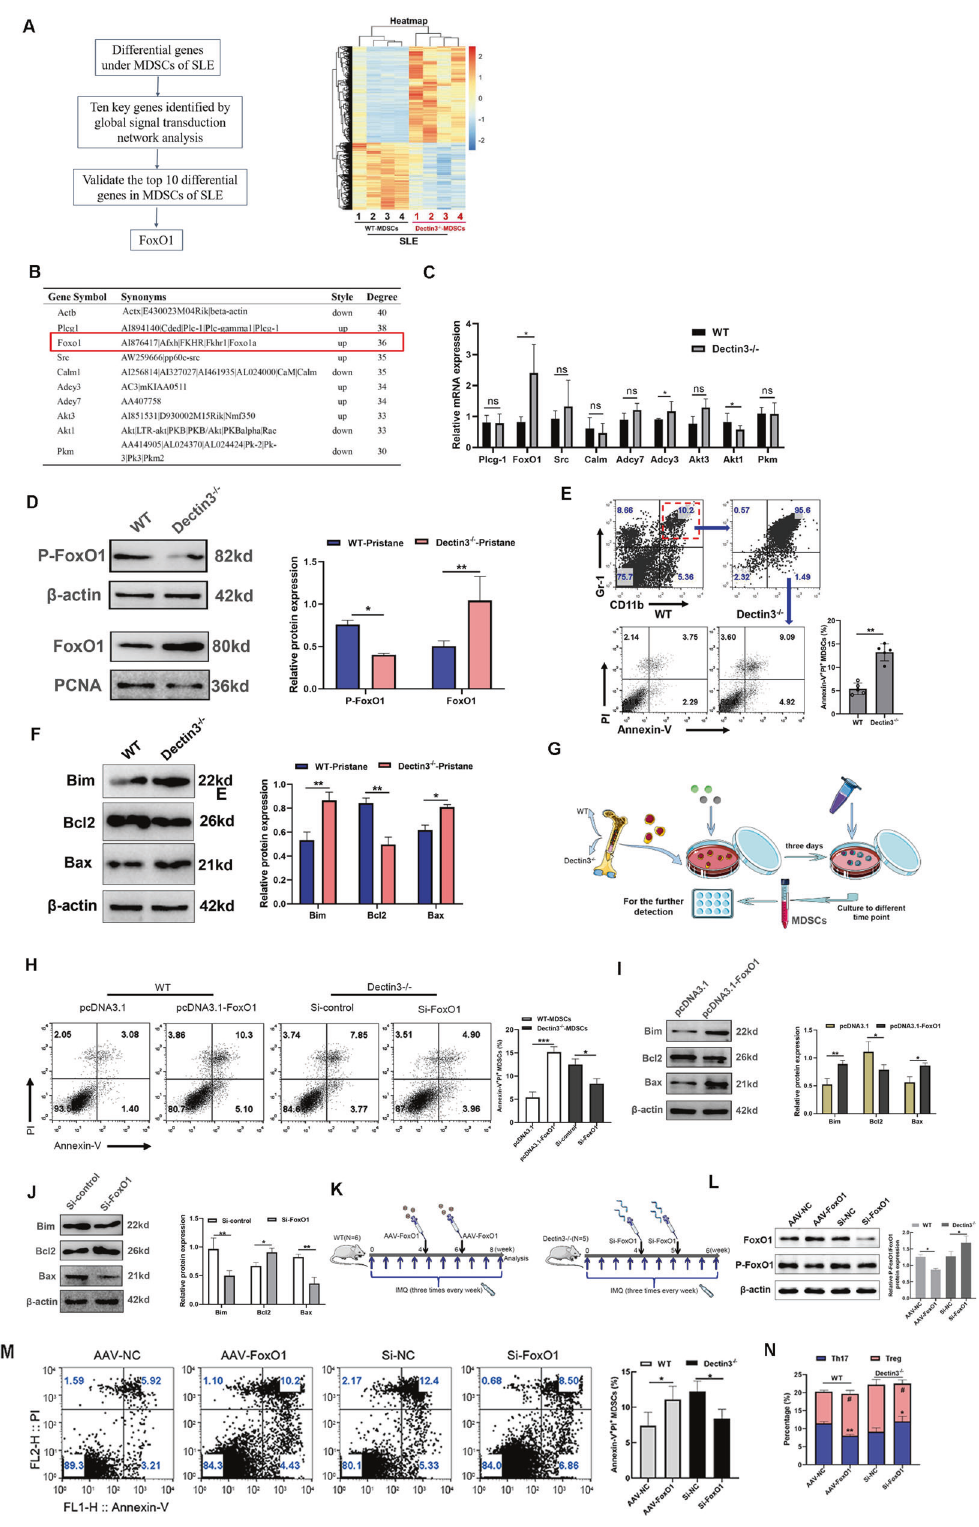
Dectin3 on M-MDSCs of peripheral blood from SLE patients (Fig. 8A, B). The results showed that Dectin3 was overexpressed on M-MDSCs of the active SLE group compared with the inactive SLE group (Fig. 8D). Moreover, the expression FoxO1 in M-MDSCs of peripheral blood from SLE patients was detected by fl